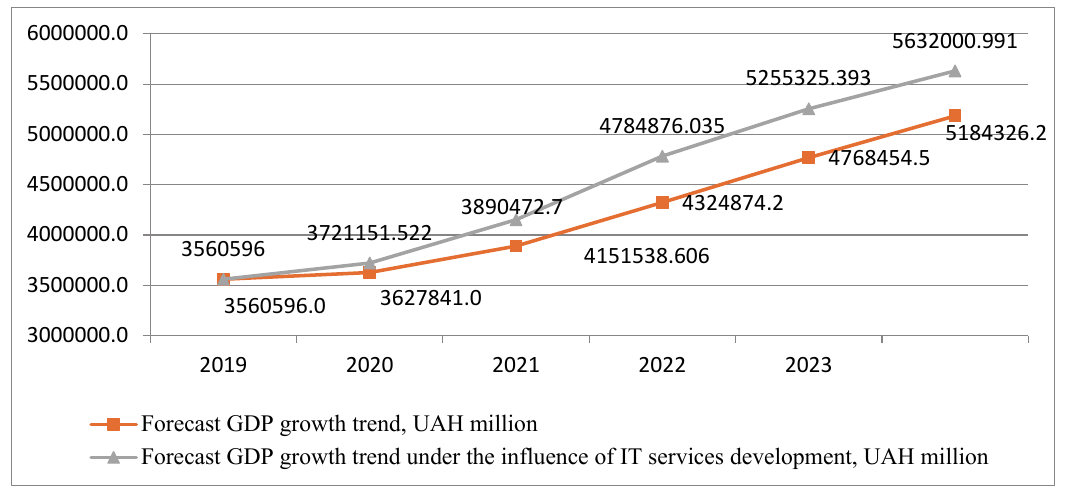
Fig. 7. Forecast of Ukraine's GDP growth under the influence of the IT sector development in accordance with certain trends Source: calculated by the